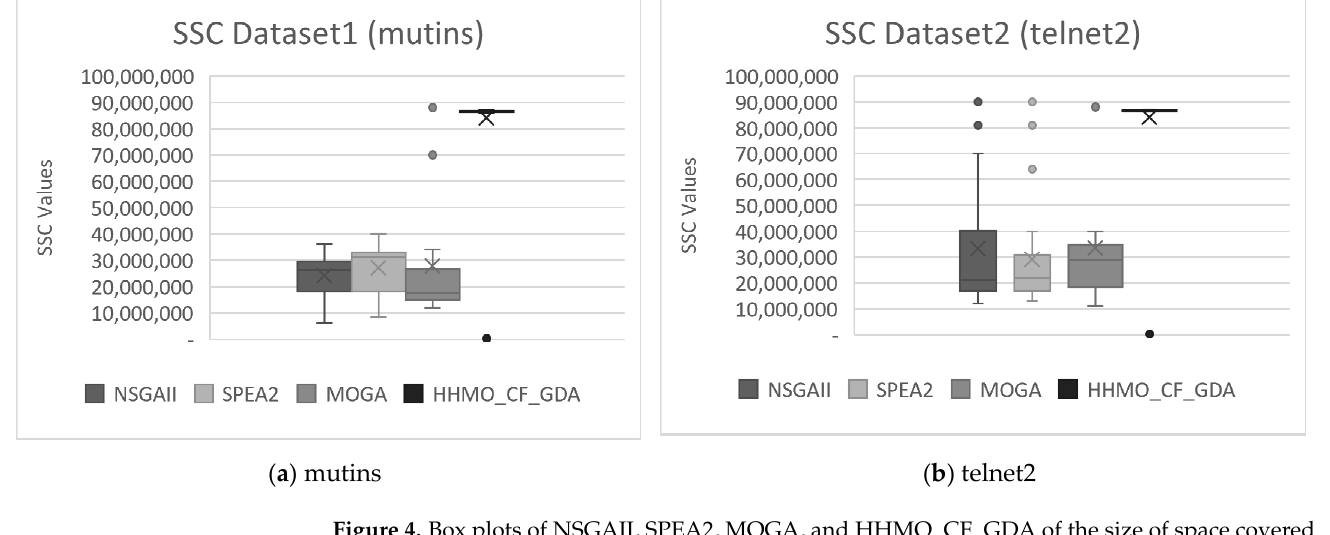
Figure 4. Box plots of NSGAII, SPEA2, MOGA, and HHMO_CF_GDA of the size of space covered (SSC) on the mutins and telnet2 datasets: ( a ) mutins box plots; ( b ) telnet2 box plots.